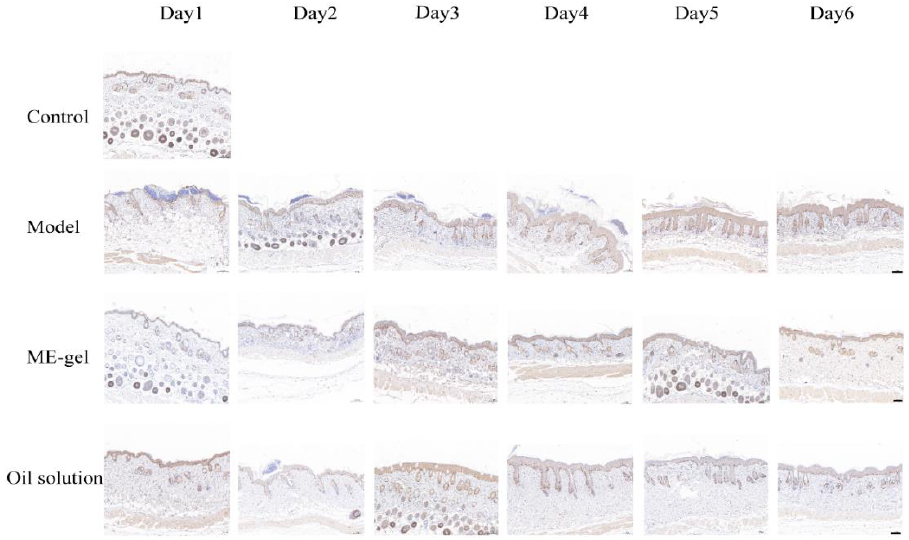
Figure 10. Effects of IR on the expression of Ki67 on the back skin of psoriatic mice (magnification 100 × ; scale bar 100 µm).